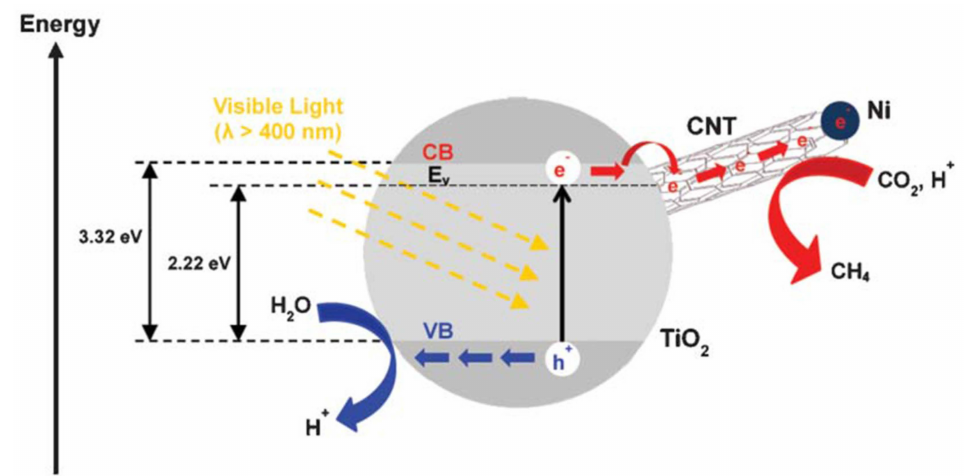
Figure 14. Charge transfer mechanism for the reduction of CO 2 with H 2 O. Reprinted with permission from Royal Society of Chemistry, 20 December 2021 Ref.